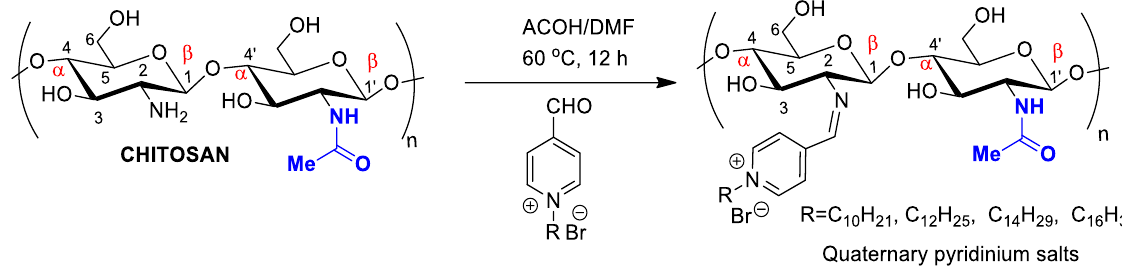
Figure 5. Chitosan nanoparticles functionalized by long-chain pyridinium salts to increase antimicrobial effectiveness.